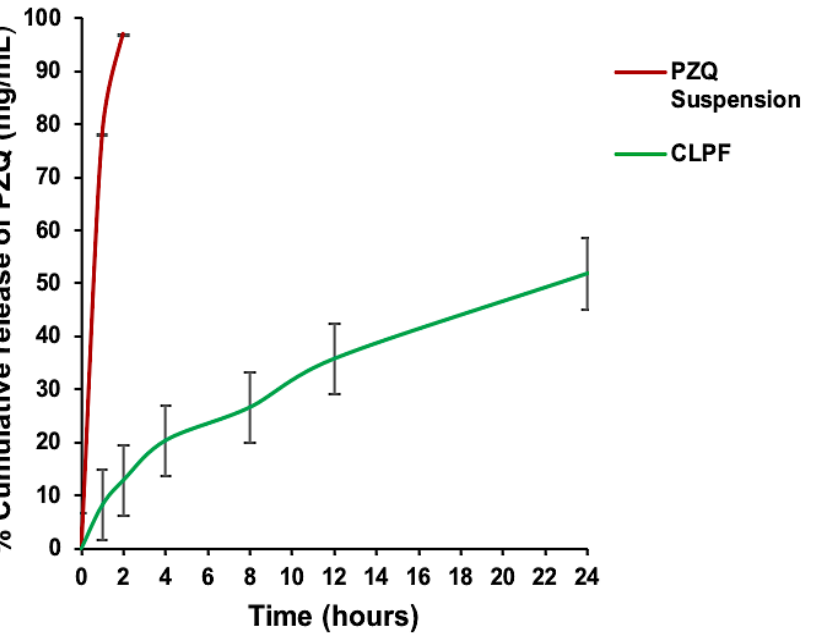
Figure 8. In vitro release profile of native PZQ suspension, PZQ-loaded SLNs (CLPF) after day 120. Temperature = 37 ± 1 ◦ C, Release medium = PBS, pH = 7.4 (containing 0.002% Tween 80) ( n = 3, mean SD).